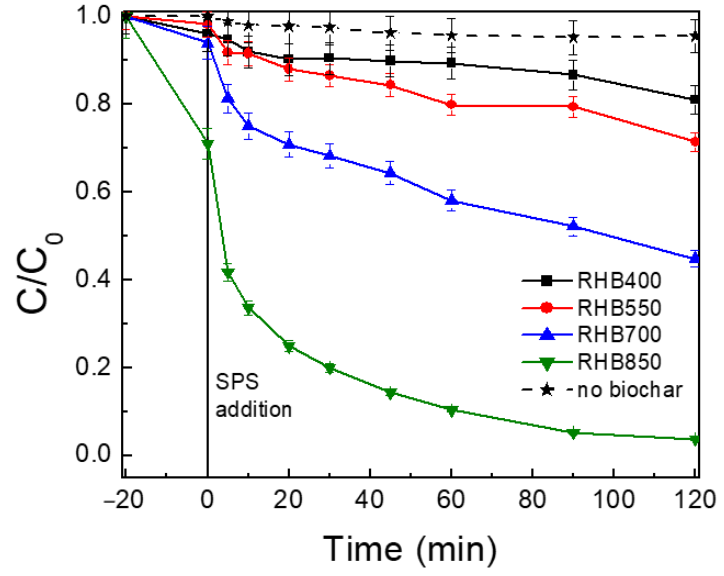
Figure 7. Effect of pyrolysis temperature on 500 µ g/L sulfamethoxazole (SMX) degradation with 100 mg/L biochar and 500 mg/L sodium persulfate (SPS) in ultrapure water (UPW) and inherent pH and temperature. SPS was added at t = 0.